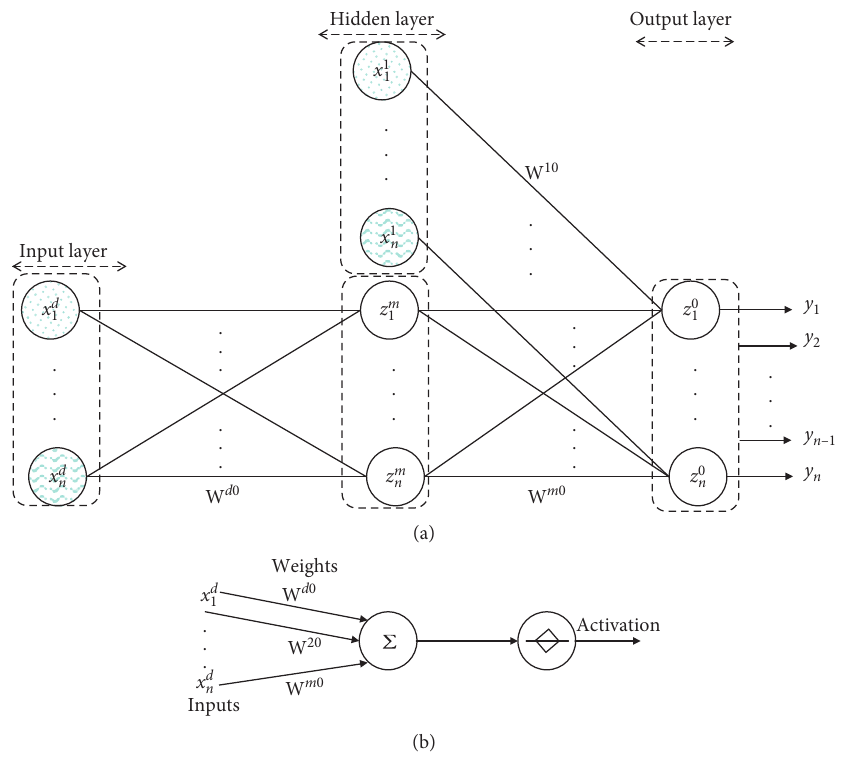
Figure 6: ANN for deflection